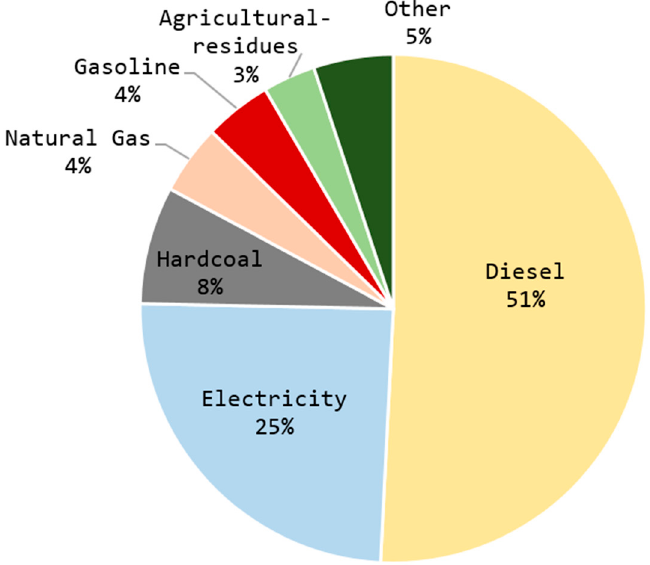
Figure 1. Global fuel share in the agricultural sector in 2014. (Electricity production share- Coal: 41%, natural gas: 22%, nuclear: 11%, hydro: 16%, other renewable (solar, wind, biomass): 6%, oil at 4%) [6].